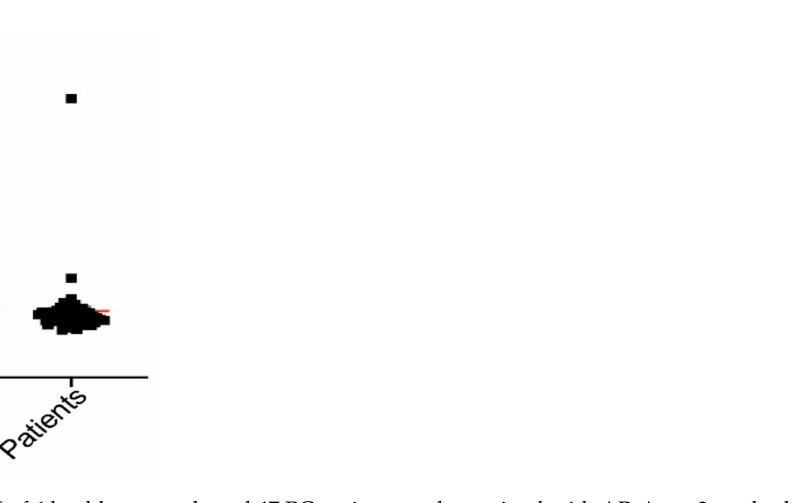
Figure 5. Chr X CN of 6 healthy controls and 47 PC patients as determined with AR-Amp-2 method. The threshold was set at 2. Chr X: X chromosome.